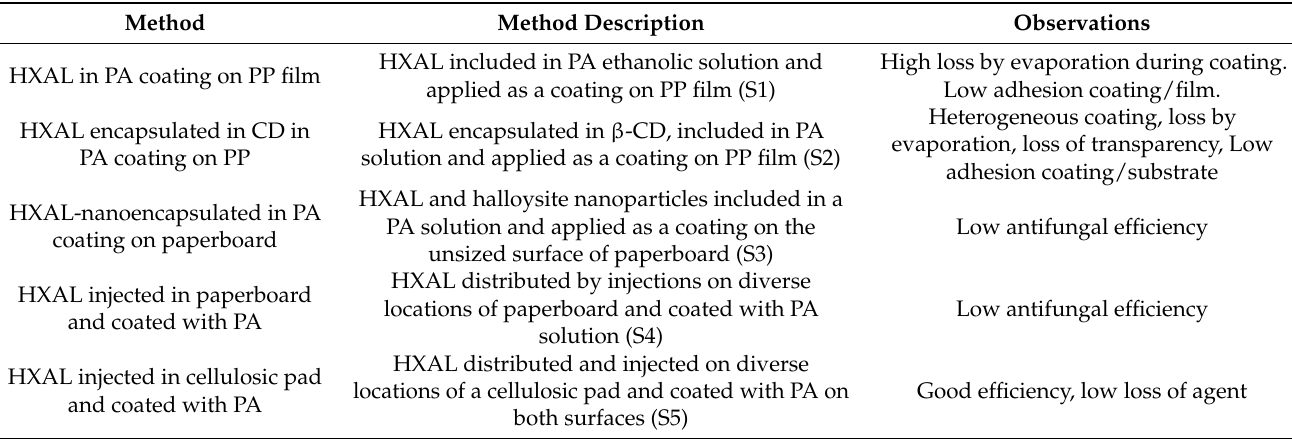
Table 1. Brief description of the diverse methods attempted to efficiently include HXAL in the packaging system. A detailed description is provided in Sections S1 to S5 of the Supplementary file.